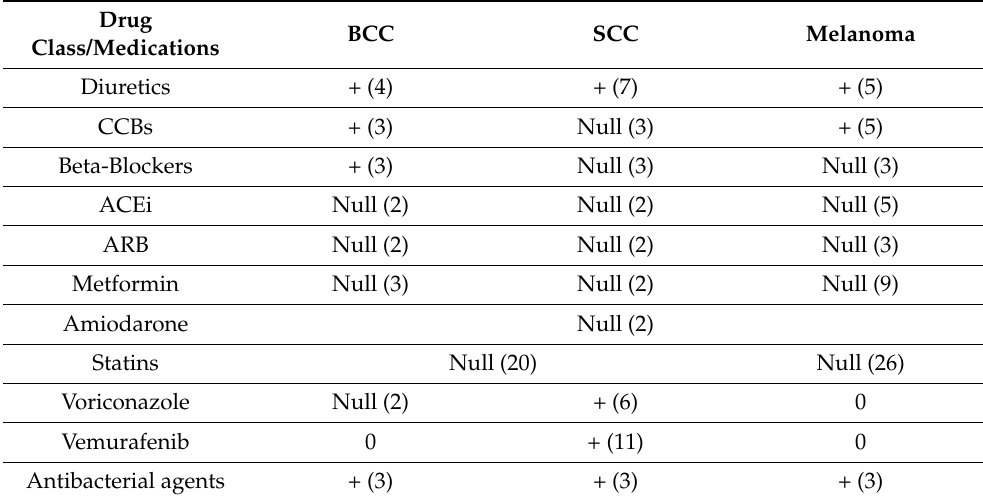
Table 2. Summary of the association between photosensitizing medications and the risk of skin cancer 1 .